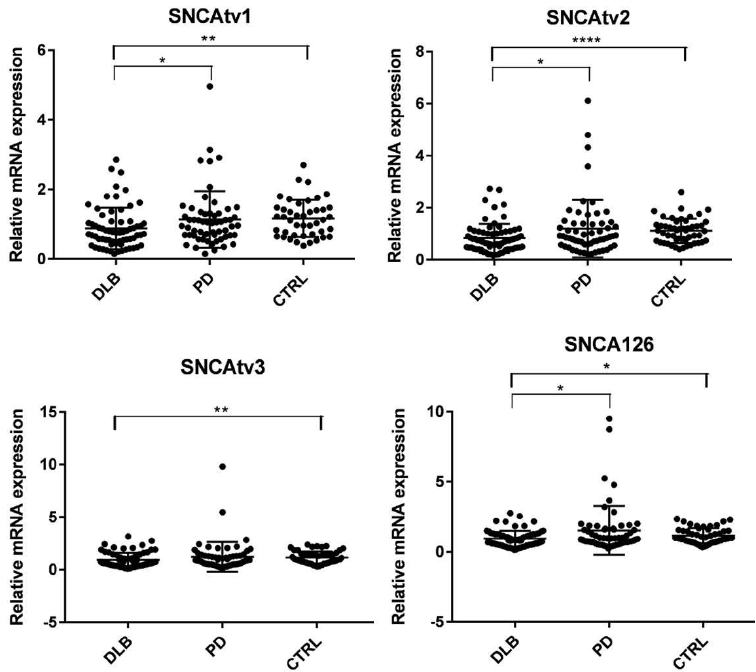
Figure 2. Expression of SNCA transcript variants in blood of DLB and PD patients, and controls. * p < 0.05, ** p <0.01, **** p <0.001.